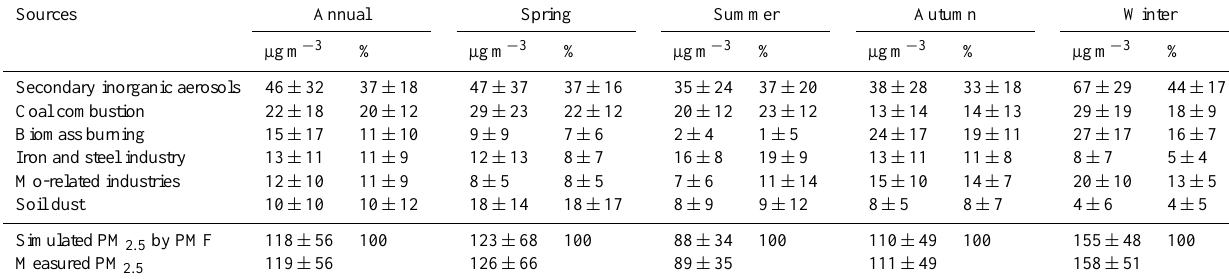
Table 4. The contributions from six identified sources of PM 2 . 5 in Chengdu. Sources Secondary inorganic